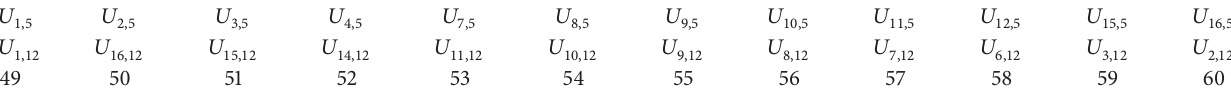
Table 6: SBVPs from electrode pair (5, 6) and electrode pair (13,